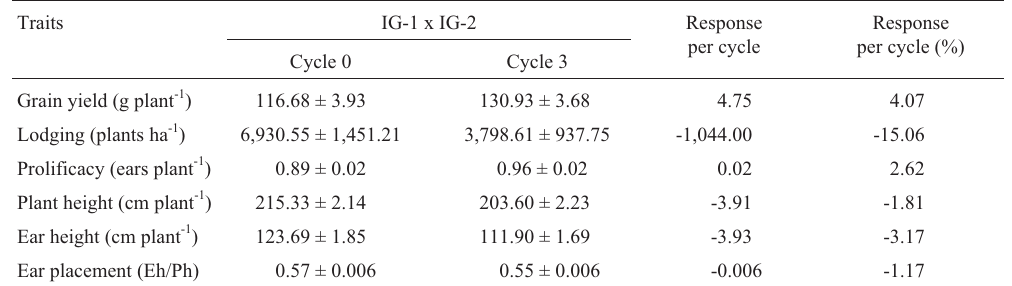
Table 2 - Mean values across environments of the interpopulation (IG-1 x IG-2) from original (Cycle 0) and after three cycles (Cycle 3) of reciprocal recurrent selection, and the responses to selection per cycle in actual units and in percentage for several traits.